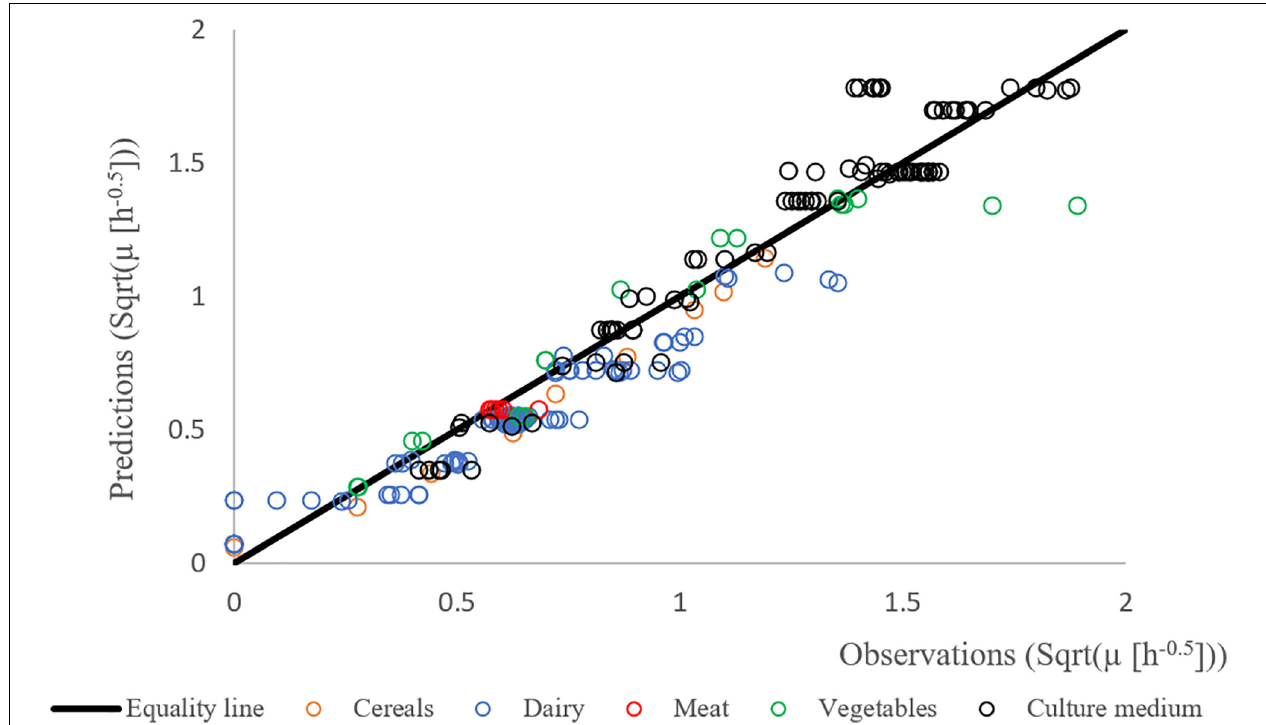
FIGURE 4 | Predicted vs. observed growth rates of different strains of B. cereus in different matrices: BHI (black), cereal- (orange), dairy- (blue), meat- (red), and vegetable-based matrices (green). The Square Root (Sqrt) link function was used.